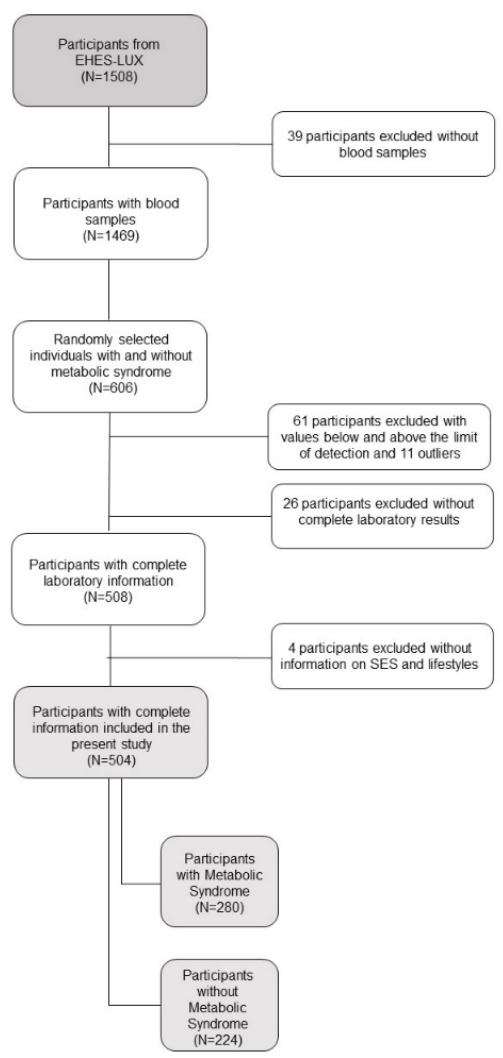
Figure 1. Flowchart sample selection. EHES-LUX: European Health Examination in Luxembourg; SES: socioeconomic status.